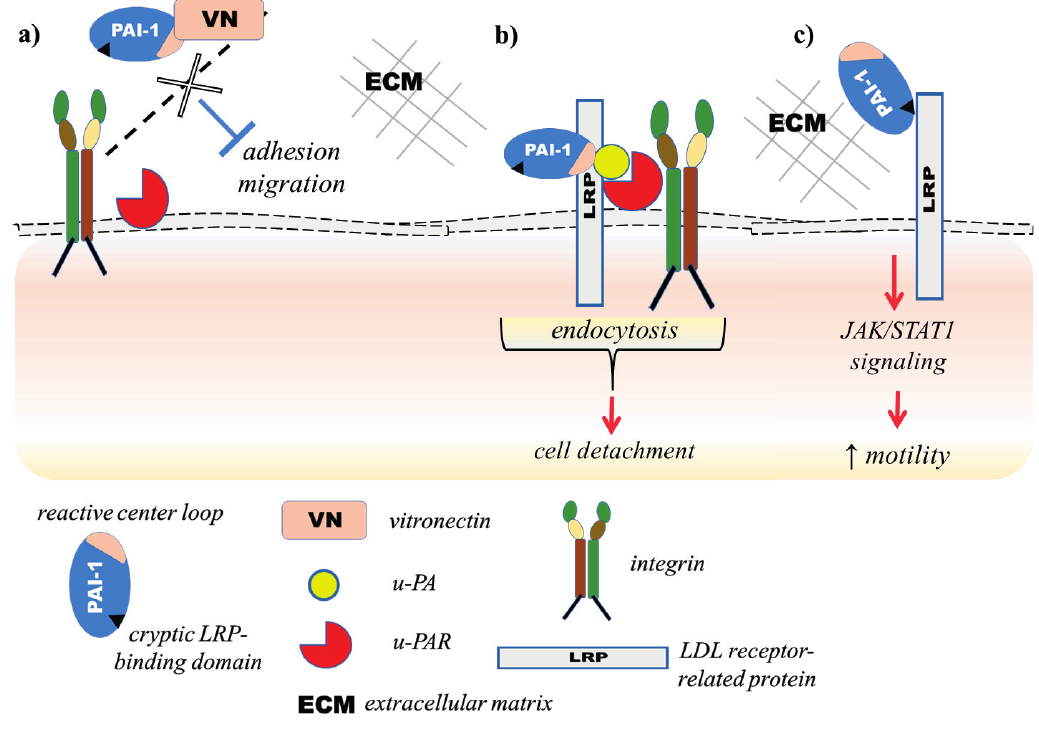
Fig. 1. Possible interactions of PAI-1 with cell surface molecules and its effects. a) PAI-1 binds VN with high affinity causing inhibition of cell adhesion and motility; b) formation, internalization and inactivation of PAI-u-PA-u-PAR complex via LRP receptor causes cell to detach; c) PAI-1 binds to LRP via secondary interaction site and acti- vates intracellular signaling that stimulates migration. PAI-1 – plasminogen activator inhibitor 1, VN – vitronectin, u-PA – urokinase plasminogen activator, u-PAR – u-PA receptor, LRP - low-density lipoprotein (LDL) receptor-related protein, ECM – extracellular matrix, JAK - Janus kinase, STAT - signal transducer and activator of